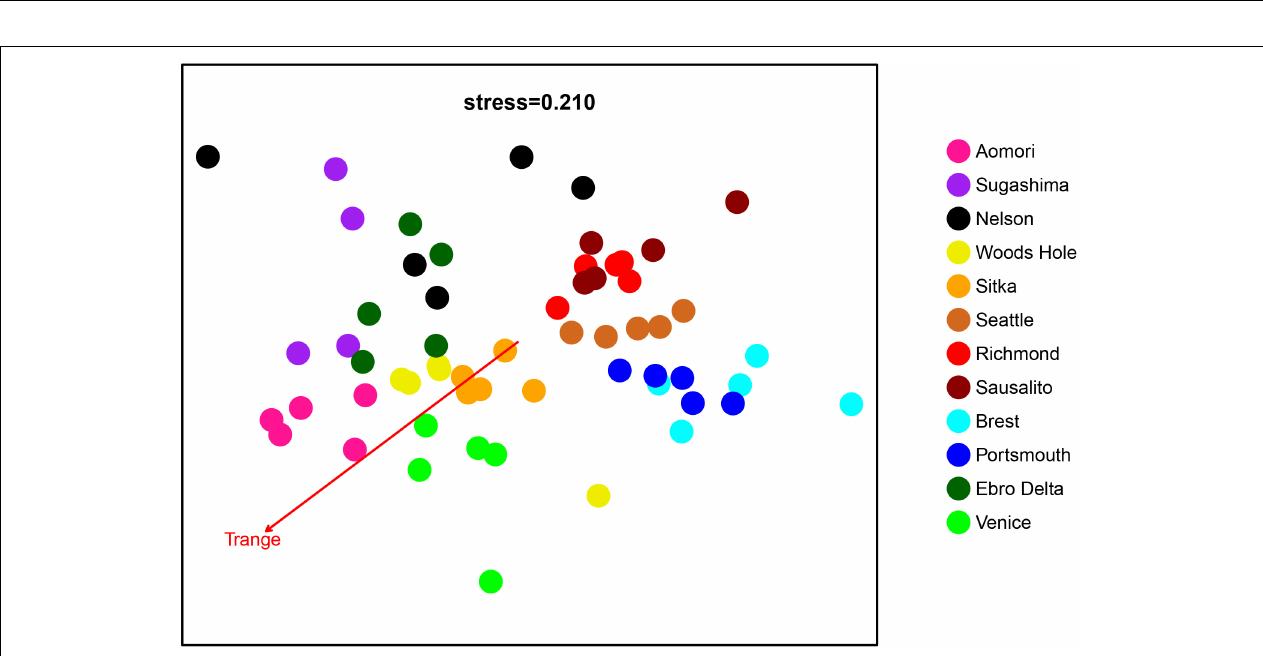
FIGURE 6 | Non-metric MDS with the 59 microbiome samples from clade A localities. Each color represents a locality. The vector corresponding to the best-fitting variable in the envfit analysis is represented.